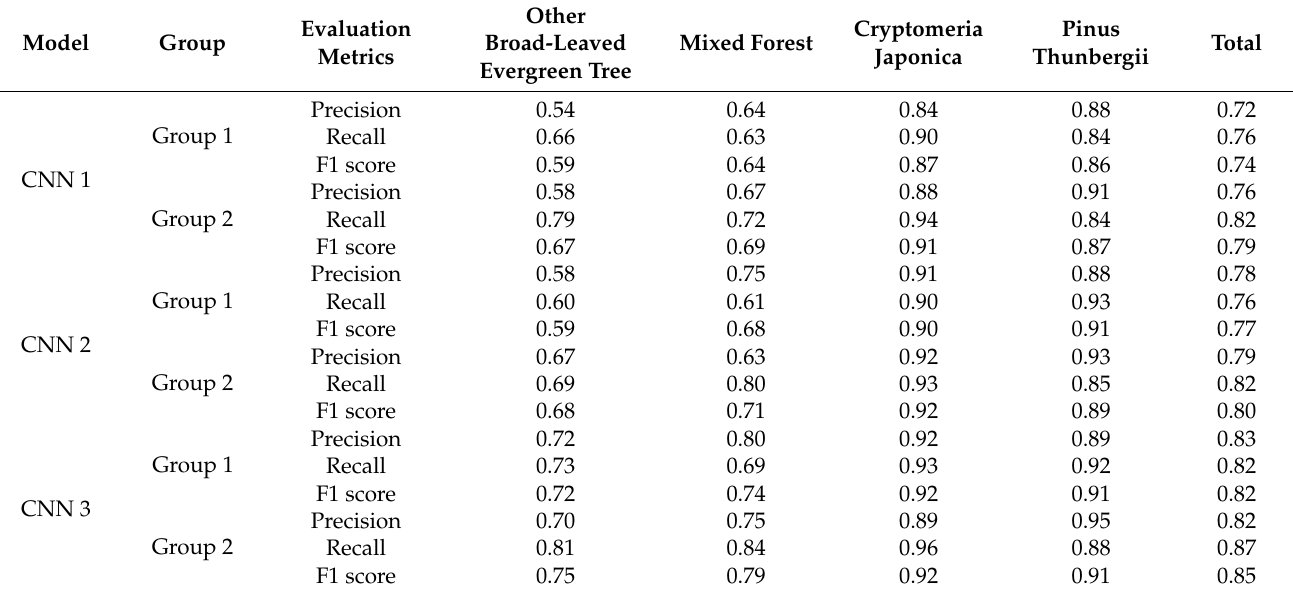
Table 5. Precision, recall, and F1 score for each model and